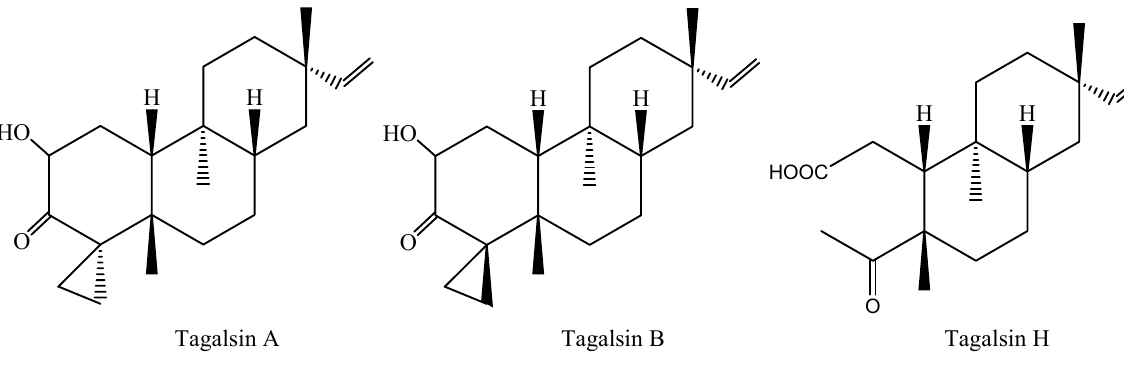
Figure 1. Structures of feeding deterrents isolated from Ceriops tagal stems and